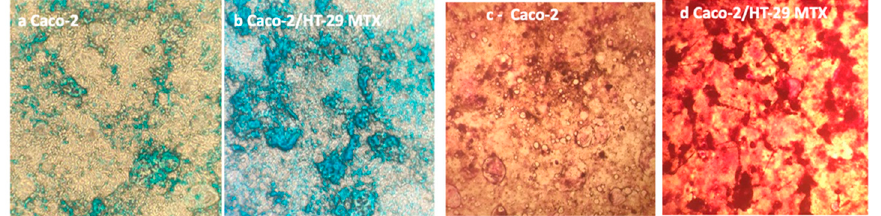
Figure 8. Alcian blue staining in: ( a ): Caco-2 monoculture and ( b ): Caco-2/HT29-MTX co-culture. Periodic Acid Schiff staining in: ( c ): Caco-2 monoculture and ( d ): Caco-2/HT29-MTX at 21 st day of culture on 6 multi-well plates. Magnification 200×.